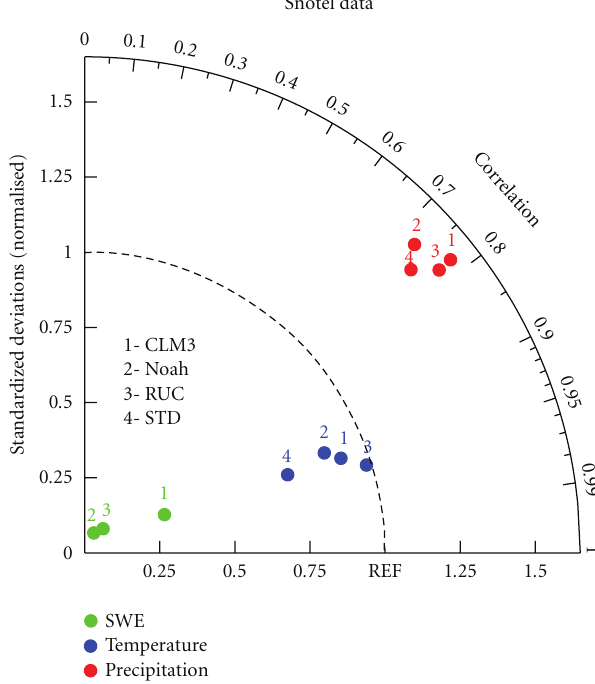
Figure 2: Comparison of the WRF-simulations with CLM3, Noah, RUC, and STD land surface schemes. Green dots are for SWE, red dots are for precipitation, and blue dots are for temperature. The standard deviations and correlation coe ffi cients are derived from the daily simulations and observations for 1 October 1995 through 30 September